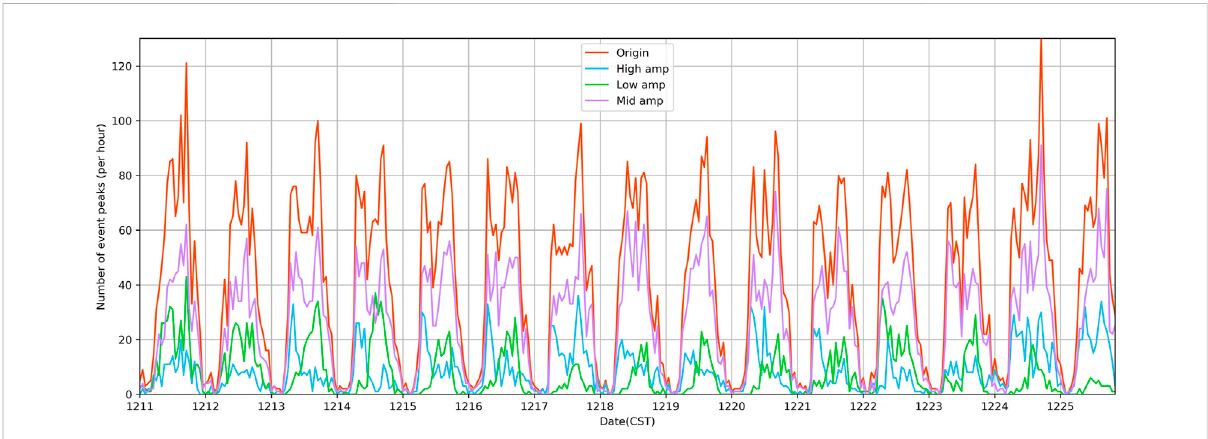
FIGURE 12 Distributions of vehicle numbers per hour for different vehicle weights. The vehicles are categorized into three classes: amplitude over 12,500 counts (High amp), lower than 5,000 counts (Low amp), and between 5,000 and 12,500 counts (Middle amp). The origin line is for total